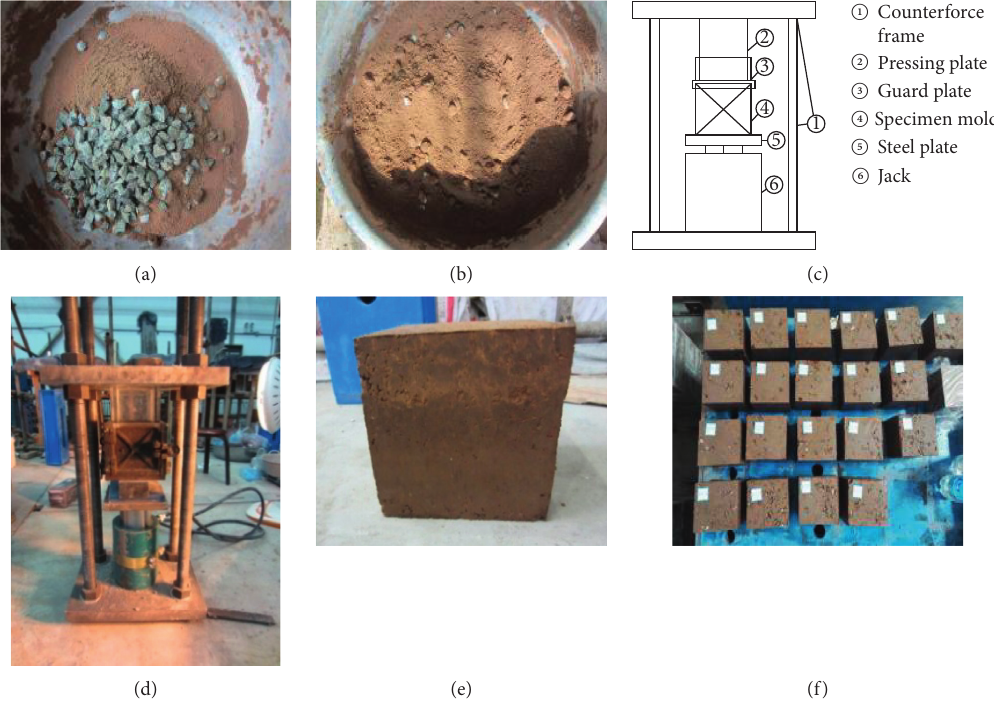
Figure 2: Manufacturing equipment and test specimens. Raw material (a), mixture mixing, (b) schematic diagram of the device (c), specimen making (d), specimen (e), and specimen maintenance